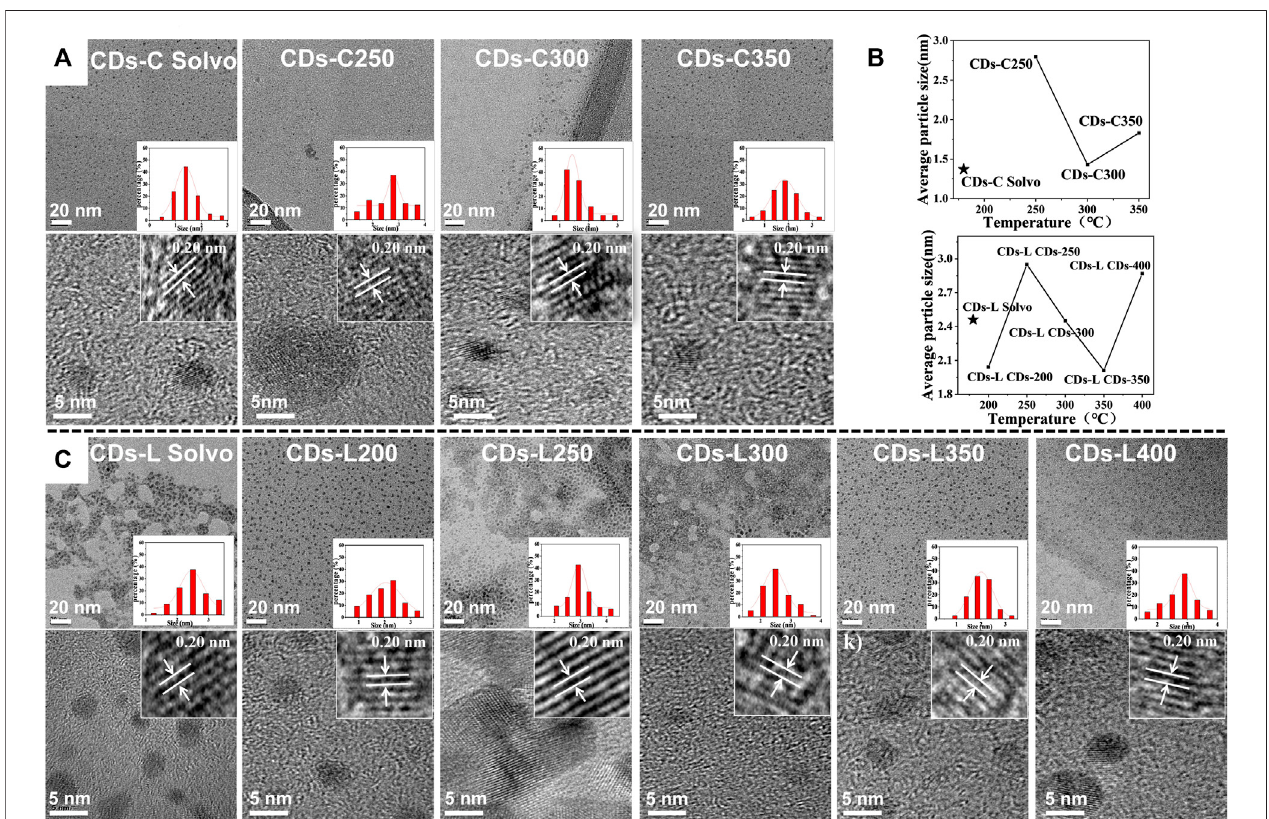
FIGURE 4 | (A) TEM images of CDs-C Solvo and CDs-C 250 – 350 (from left to right), Inset: histograms and Gaussian fi ttings of particle size distribution, HR-TEM imagesofCDs-CSolventandCDs-C250 – 350(fromlefttoright); (B) TEMimagesofCDs-LSolvoandCDs-L200 – 400(fromlefttoright),Inset:histogramsandGaussian fi ttings of particle size distribution, HR-TEM images of CDs-L Solvo and CDs-L 200 – 400 (from left to right); (C) Dotted line plot of average particle size of CDs versus reaction temperature.